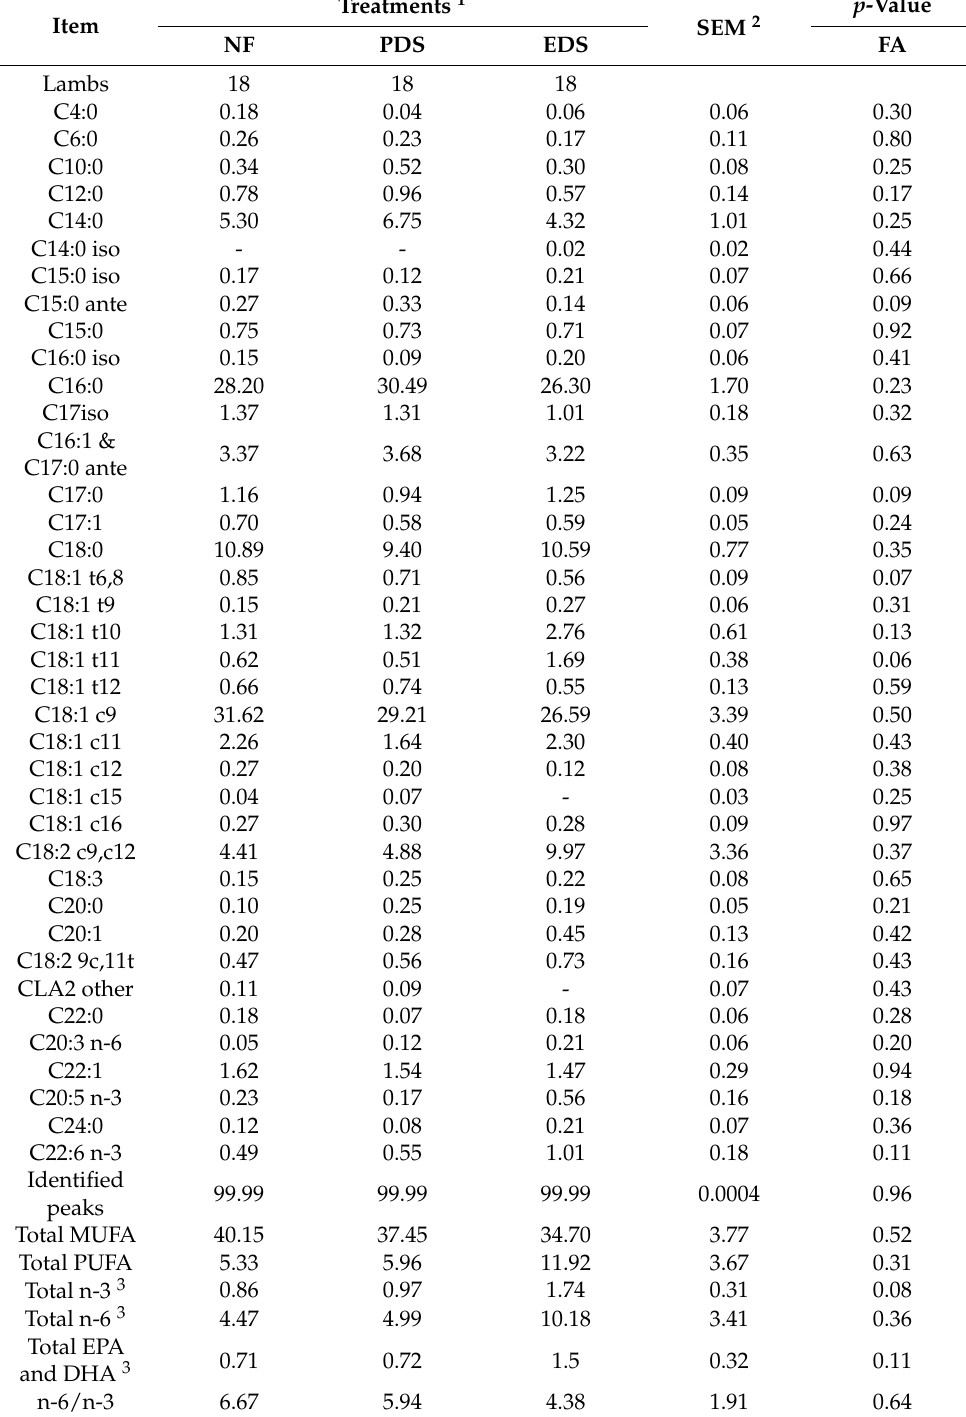
Table 6. Effect of a fatty acid enriched diet during the last 50 days of gestation on lambs’ plasma fatty acid concentration (% total fatty acid methyl esters) at